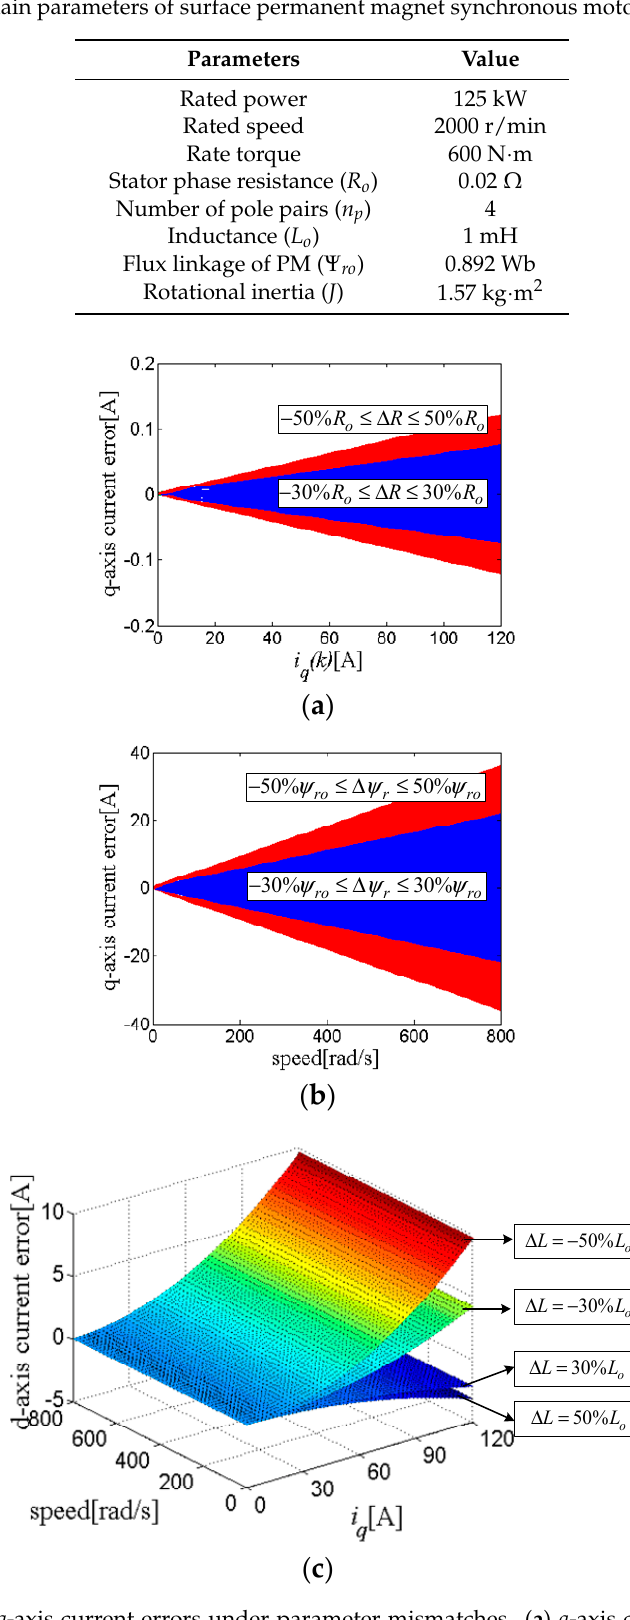
Figure 1. d - and q -axis current errors under parameter mismatches. ( a ) q -axis current error under resistance parameter mismatch; ( b ) q -axis current error under flux linkage parameter mismatch; ( c ) d -axis current error under inductance parameter